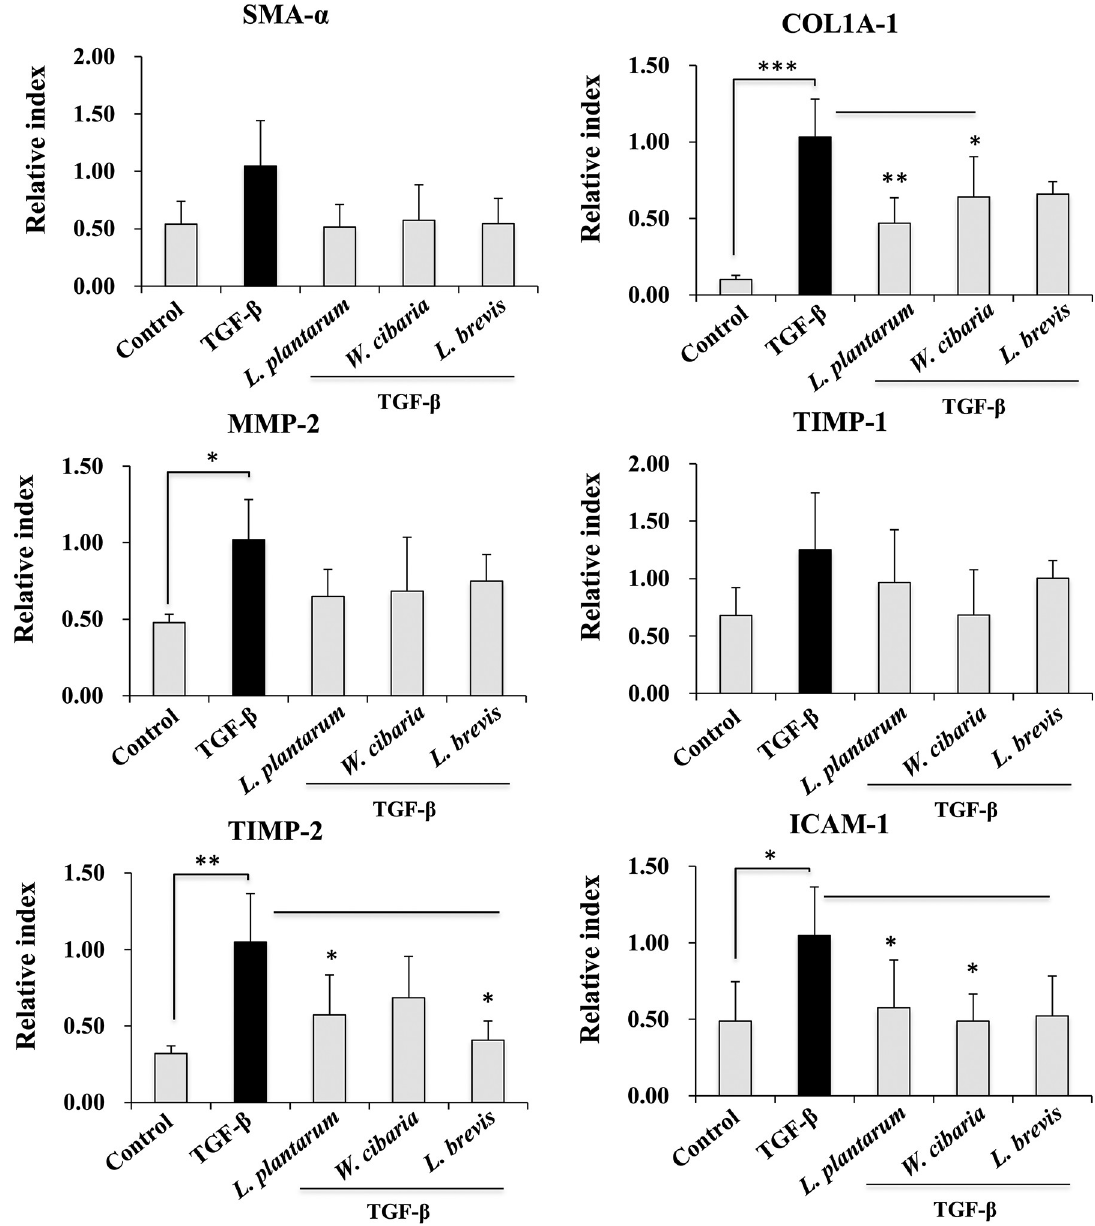
Fig 3. Effect of LAB on TGF- β induced pro-fibrogenic markers expression in LX-2 cells. Confluence LX-2 cells were treated with LAB for 48 h, then stimulated with TGF- β for 24 h. The mRNA levels of α -SMA, Col1A1, MMP-2, ICAM-1, TIMP-1, and TIMP2 were determined by RT-PCR. LX-2 cells, either with medium or TGF- β alone, were used as a negative and positive control. Two independent experiments (n = 3) were performed, and the average values (mean + S.D) are shown. � p < 0.05, �� p < 0.01, ��� p <